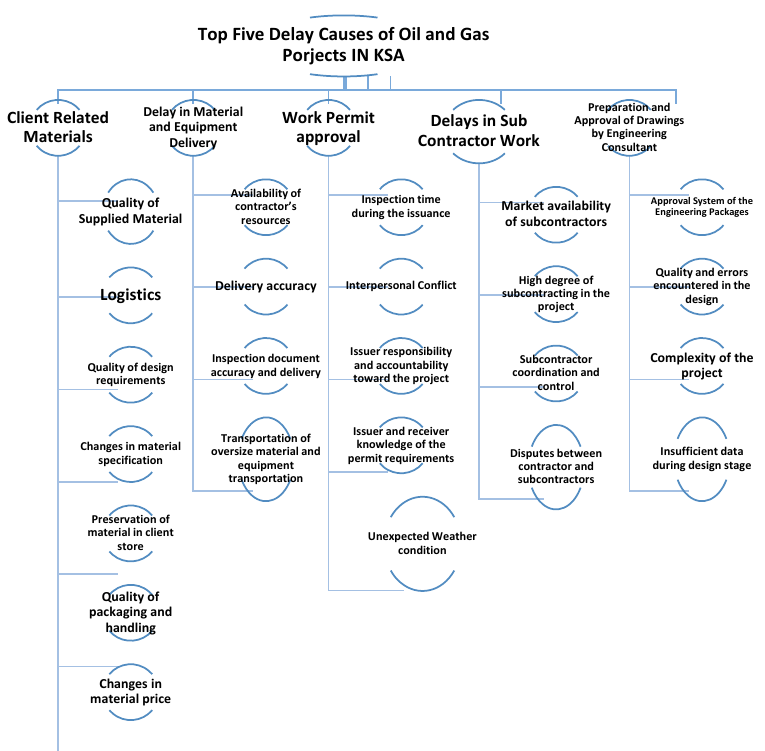
Figure 3. Root of identified causes.